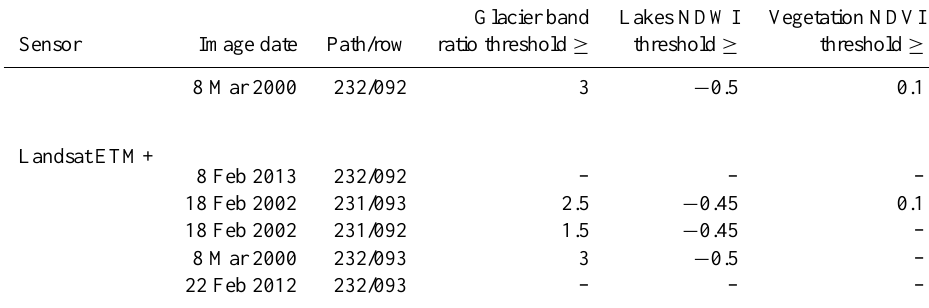
Glacier band Lakes NDWI